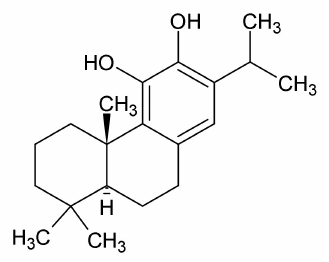
Figure 6. Carnosic